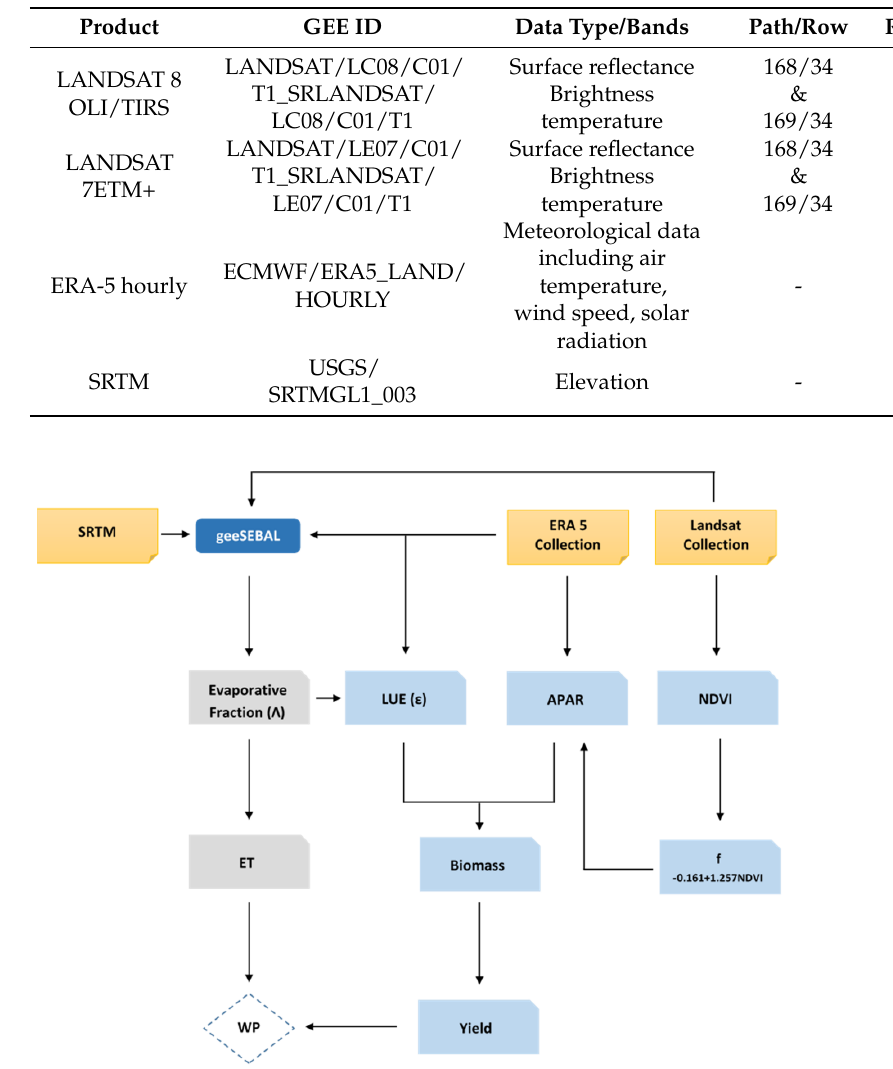
Figure 3. Workflow of the WP model within GEE.